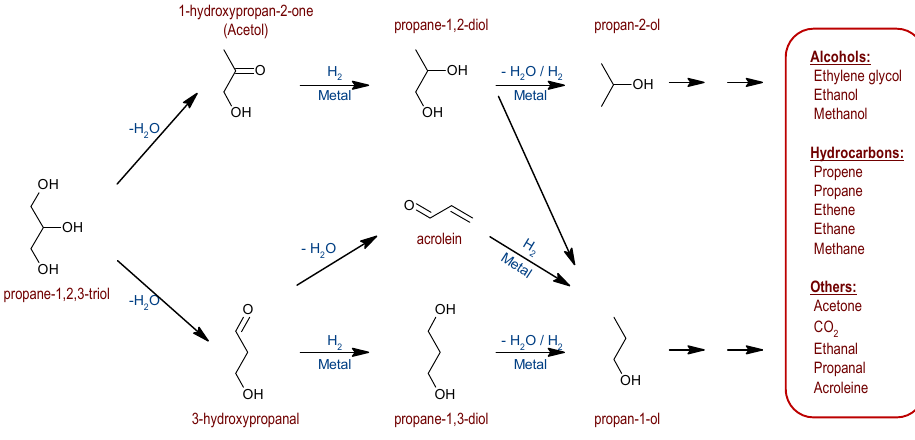
Figure 5. Glycerol hydrogenolysis pathways.